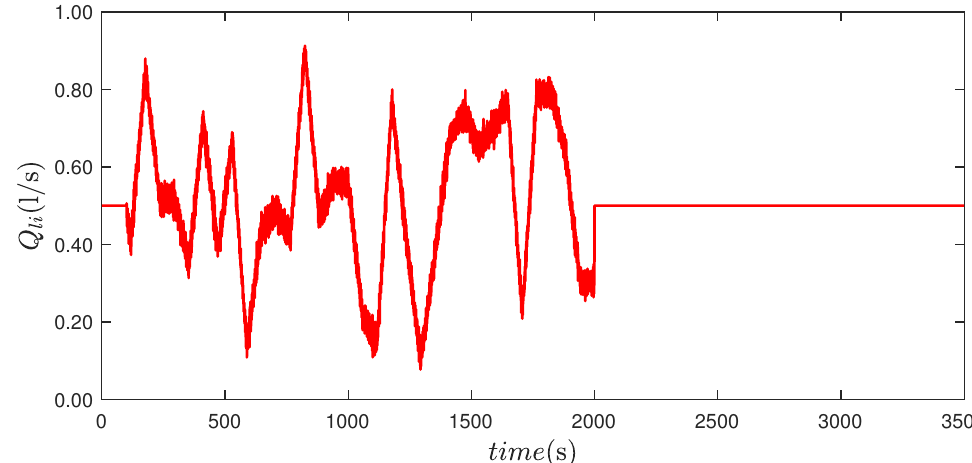
Figure 4. Separator liquid inflow, with the input disturbance from 100 s to 2000 s, and a steady-state period from 2000 s to 3500